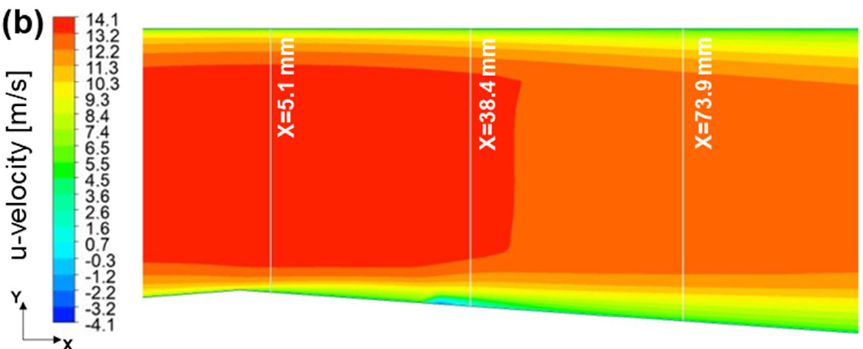
Figure 10. ( a ) Void fractions and ( b ) u-velocity contour